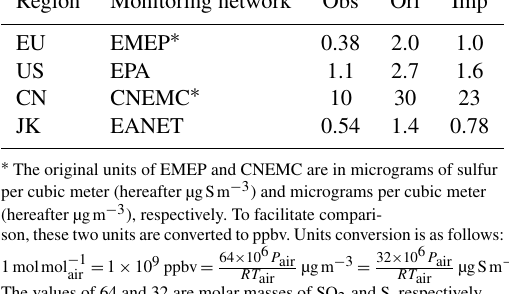
(hereafter g ) and micrograms (hereafter µ g ). R = 8.314 Jmol − 1 K − 1 is the ideal gas constant. T air (288 K used here) is